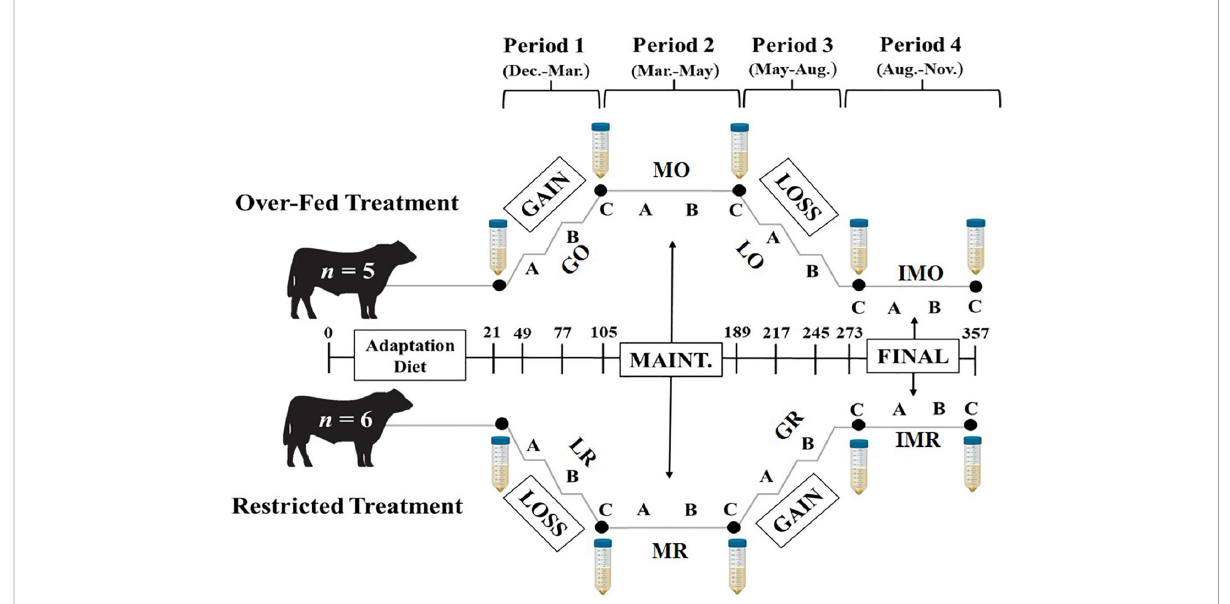
FIGURE 1 Project timeline with two nutrition pathways: Over-Fed and Restricted, with four respective nutritional treatments per pathway. Sample collections followed a 21 d diet adaptation period prior to treatments. The treatments include: Gain to Obesity (GO), Maintenance at Obese BCS (MO), Loss after Obesity (LO), Maintenance at Ideal Adiposity after Obesity (IMO), Loss from Nutrient Restriction (LR), Maintenance at Restriction BCS (MR), Gain after Nutrient Restriction (GR), and Maintenance at Ideal Adiposity after Nutrient Restriction (IMR). Each treatment includes semen collection for cytokine concentrations for initial and every 84 d (large falcon